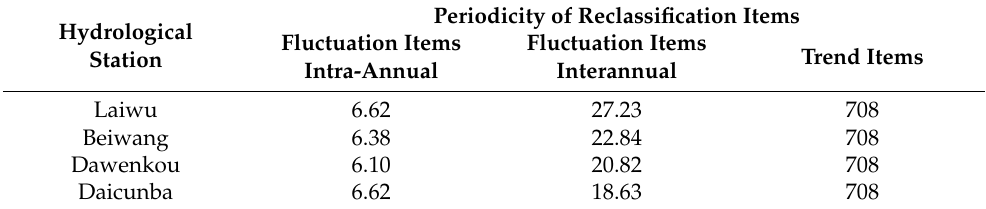
Table 4. The periodicity of the reclassification items for different hydrological